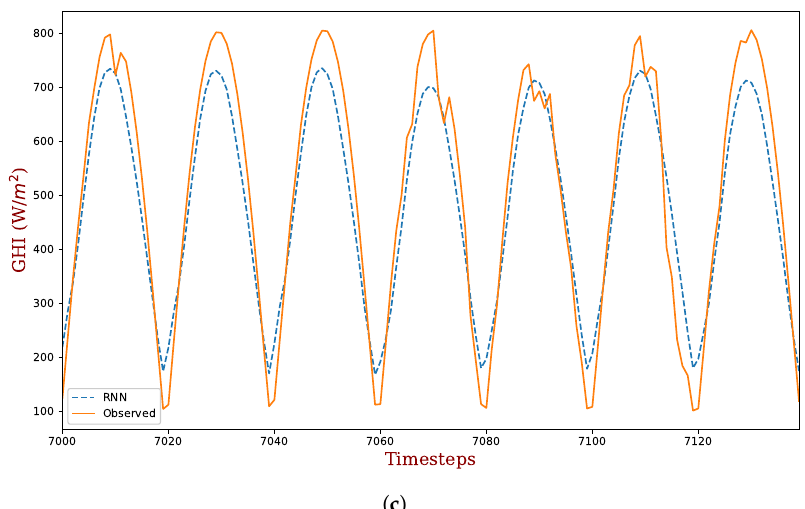
Figure 14. Prediction for three weeks of 2020 with RNN. ( a ) Week 16 RNN. ( b ) Week 33 RNN. ( c ) Week 51 RNN. Table 2. Hyperparameter values for grid-search.